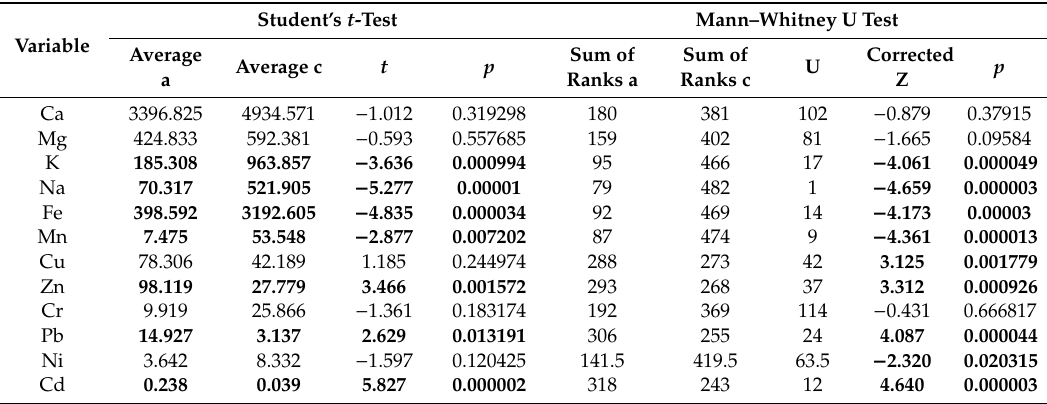
Table 4. Analysis of di ff erences between the composition of new (a) and composted samples after 20 h irradiation (c)—the highlighted results are significant with p < 0.05.